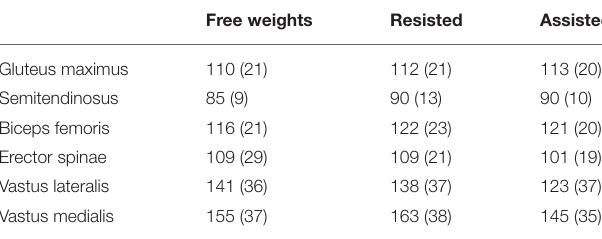
= 0.50) when compared to resisted deadlifts. There were no TABLE 2 | Neuromuscular activation for the whole movement (% of